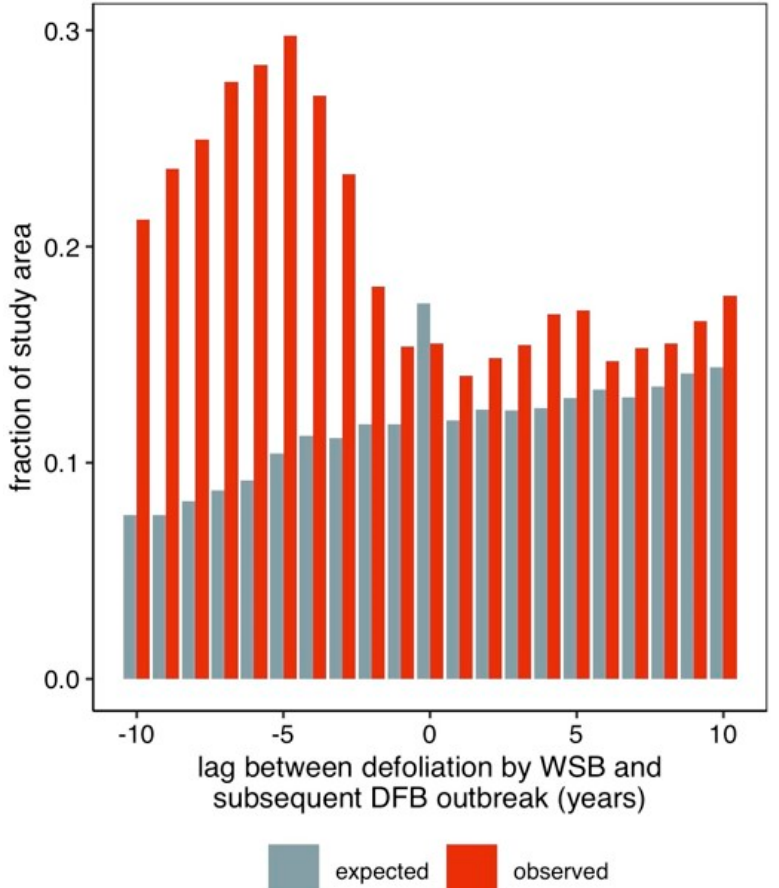
Figure 4. The observed and expected proportion of pixels affected by DFB and WSB by temporal lag. Negative values on the x-axis indicate that WSB defoliation occurred prior to DFB outbreak, whereas positive values indicate that WSB defoliation occurred after DFB outbreak; absolute values on the x-axis give the number of years (i.e., lag) between outbreaks of the two species. Red bars that exceed the height of grey bars indicate that spatiotemporal overlap of the two biotic agents occurs more often than expected due to chance at a given lag.